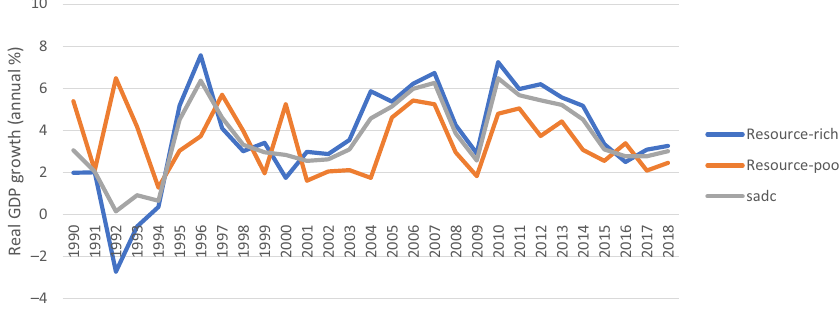
Figure 1. Trends in GDP growth